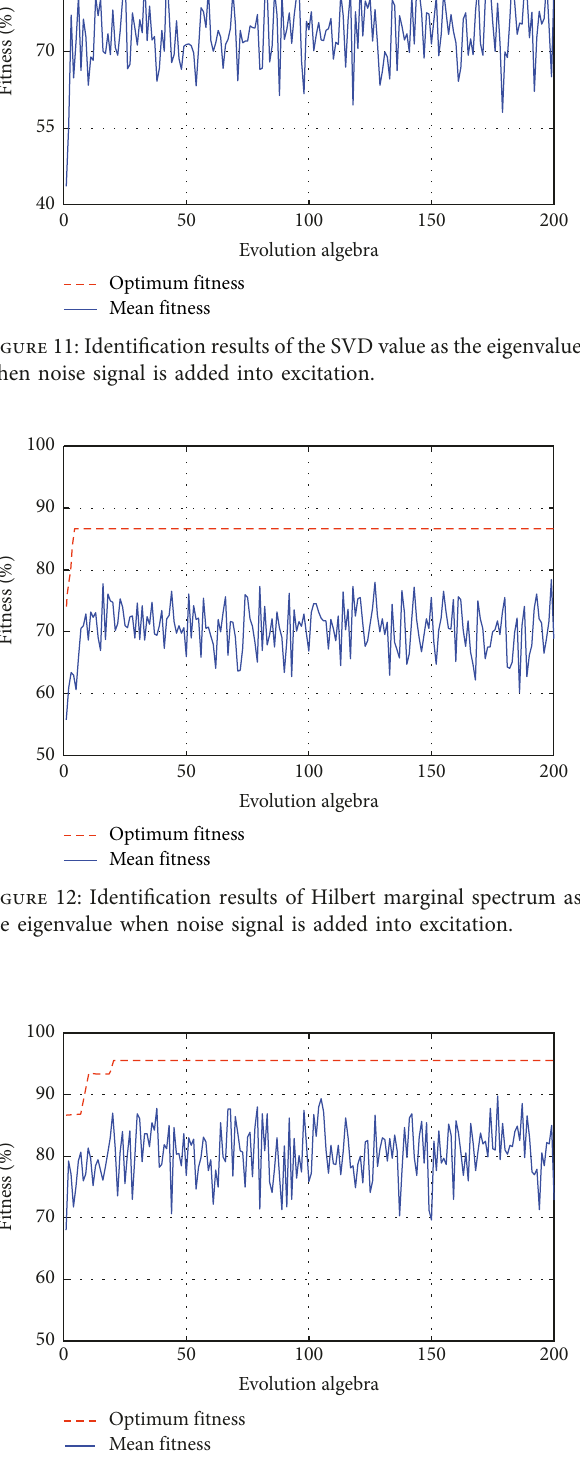
Figure 13: Identification results of the SVD value and Hilbert marginal spectrum as the eigenvalue when noise signal is added into